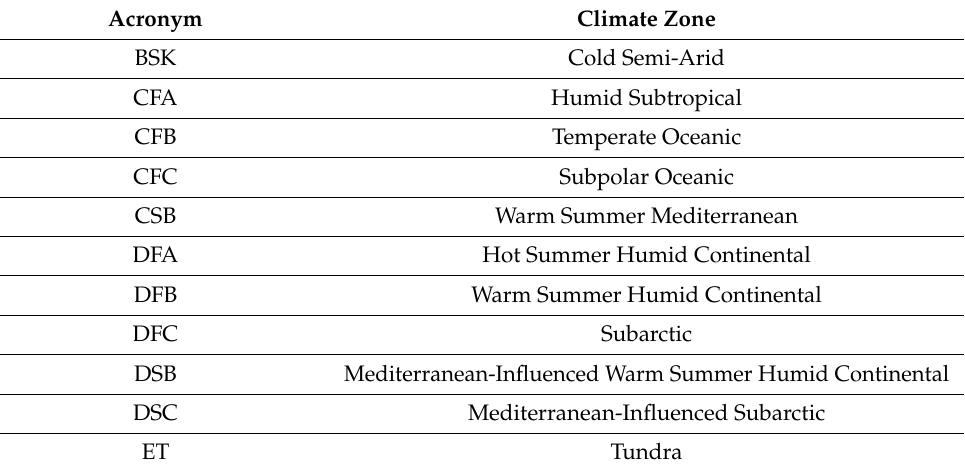
Table 1. The climate zones of the considered catchments based on the Köppen–Geiger